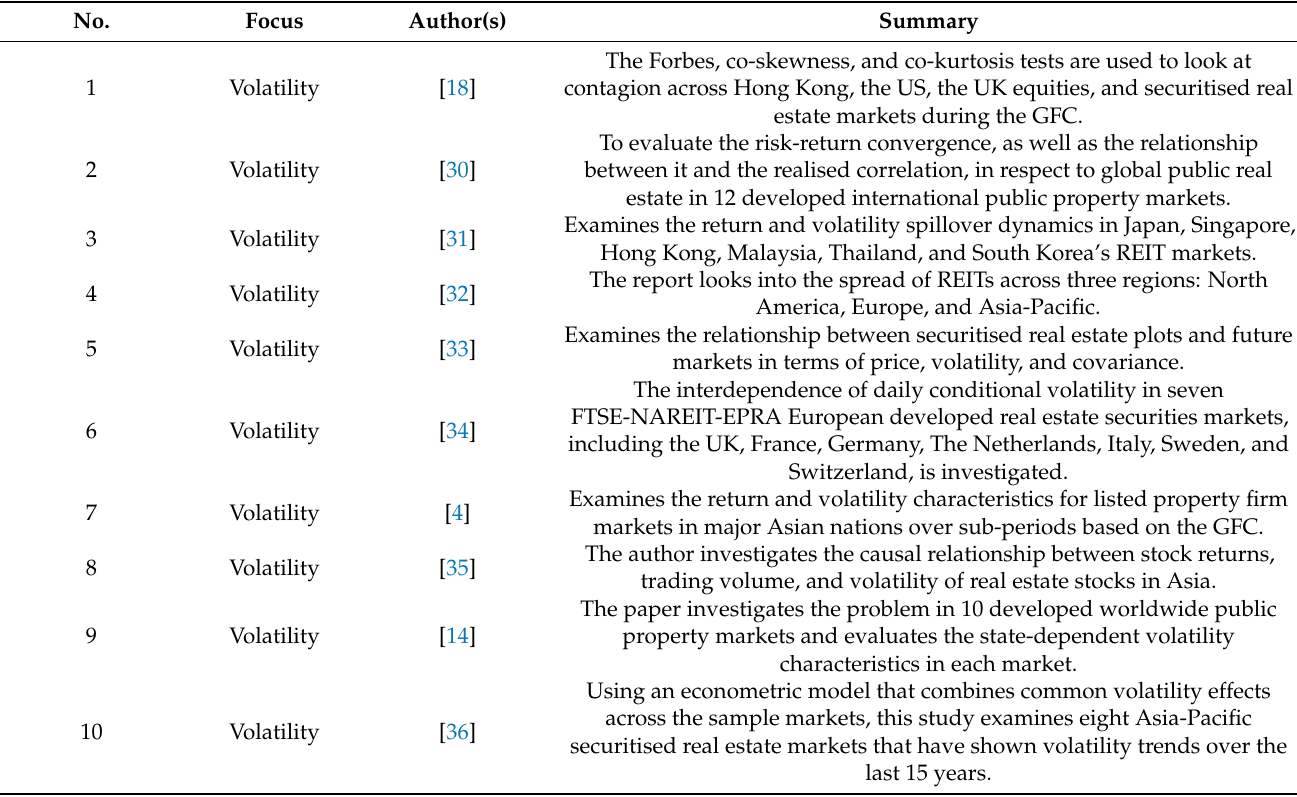
Table 2. Summary of Previous Studies of Volatility on Real Estate